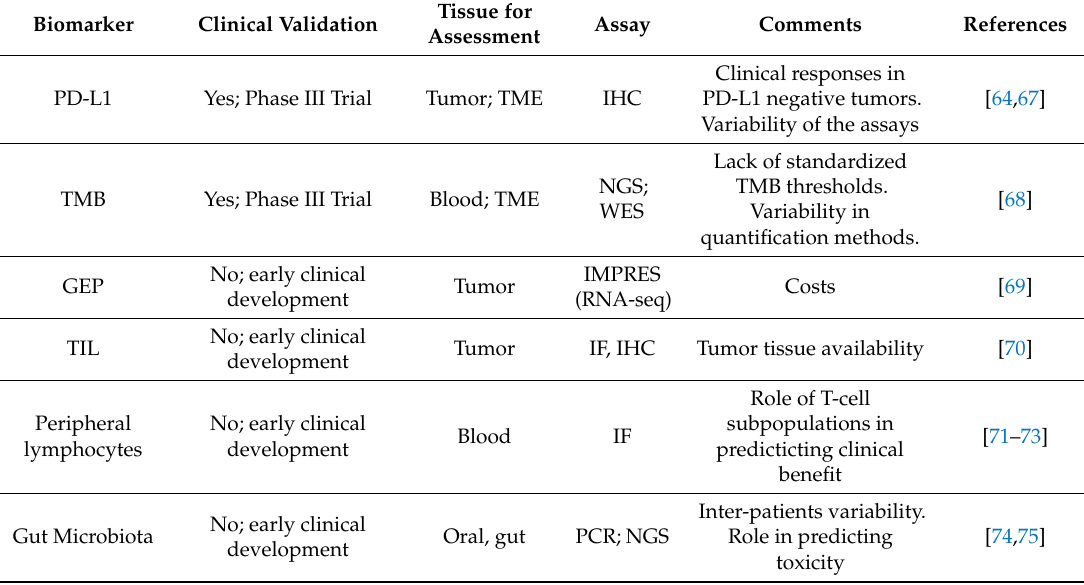
Table 2. Selected Biomarkers in